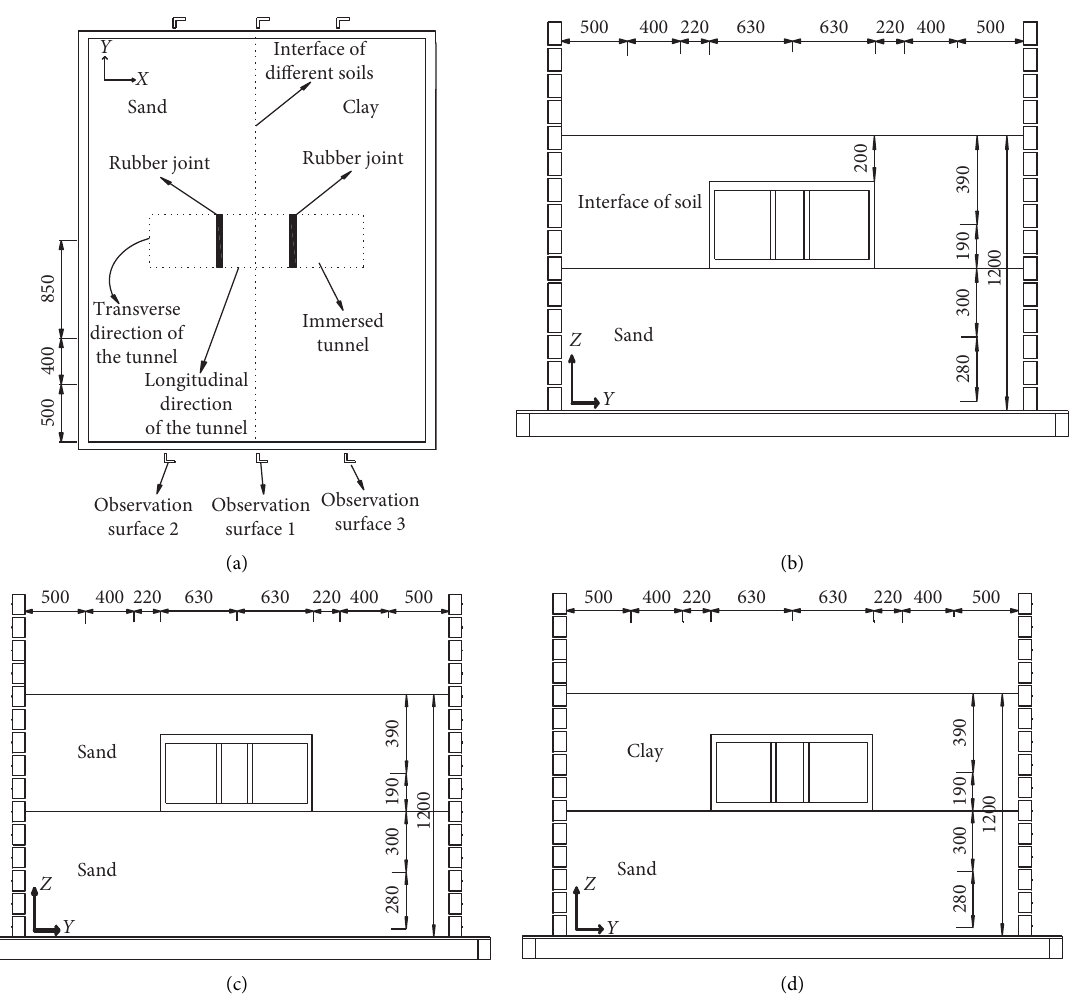
Figure 3: Soil layer distribution of the site. (a) Layout diagram of boundary line of soil layer and observation surface. (b) Observation surface 1. (c) Observation surface 2. (d) Observation surface 3.